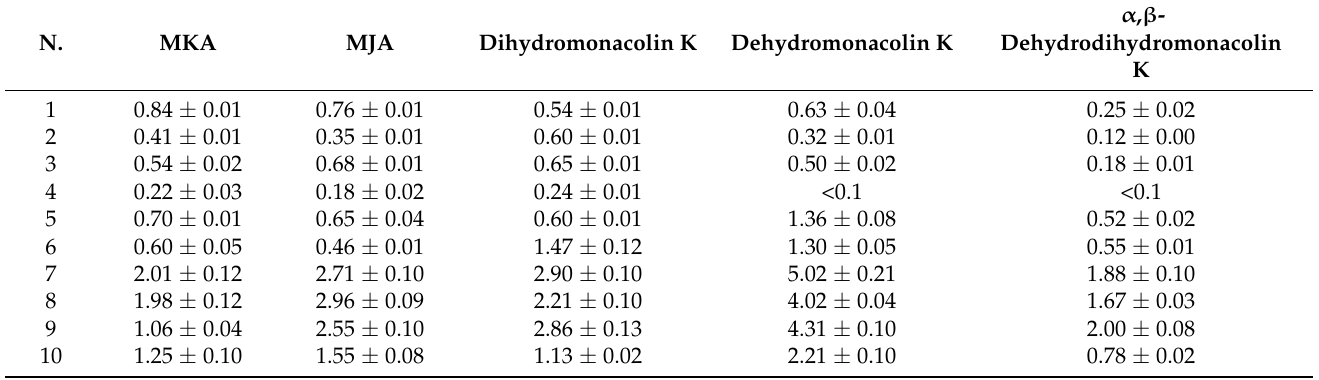
Table 2. Monacolin K, acid form, monacolin J, acid form, dihydromonacolin K, dehydromonacolin K and α , β - dehydrodihydromonacolin K contents in dietary supplements containing red yeast rice as the main active ingredient. Values are reported as mean mg/serving ±